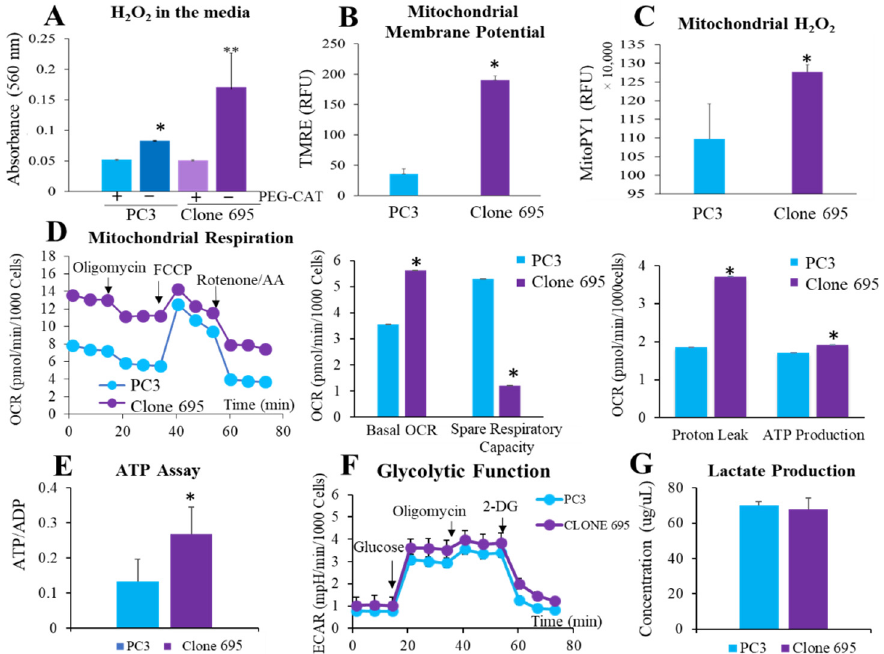
Figure 3. Clone 695 cells shows an increase in H 2 O 2 production and mitochondrial respiration compared to PC3 cells. ( A ) H 2 O 2 released into the media after 24 h incubation using an Amplex red assay. PEG-CAT (500 unit) was added for negative control. ( B ) TMRE staining shows mitochondrial membrane potential. ( C ) MitoPY1 intensity indicating mitochondrial H 2 O 2 production. RFU = Relative fluorescence unit. ( D ) Seahorse Mitochondrial Stress Test. Respiration graphs calculated by response to inhibitors (oligomycin, FCCP, and Rotenone/Antimycin A (AA)). ( E ) ATP/ADP ratio kit showing ATP produced. ( F ) Seahorse Glycolytic stress test. Graph values calculated by response to inhibitors added during assay (Glucose, Oligomycin, and 2-DG). ( G ) Lactate Assay (measuring d-lactate). * p -value < 0.05, ** p -value < 0.09.